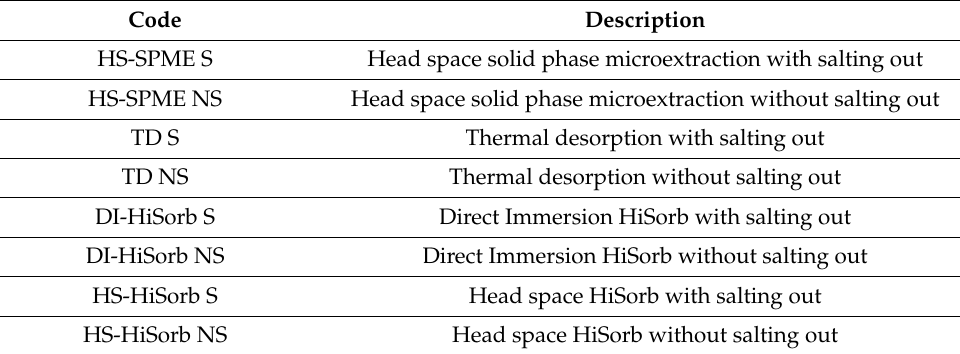
Table 1. Details and codes used to describe each extraction technique with and without salting out